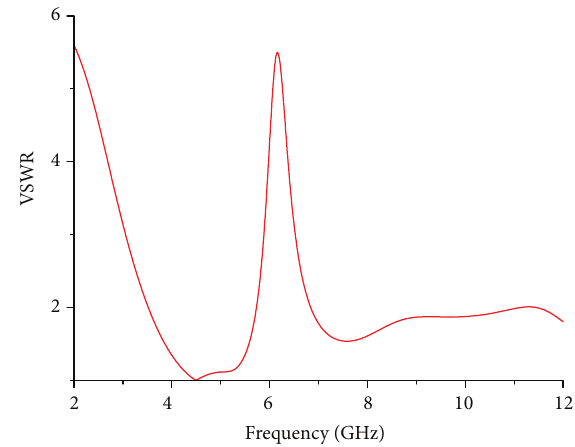
Figure 8: Simulated VSWR of the high frequency band-notched UWB antenna.